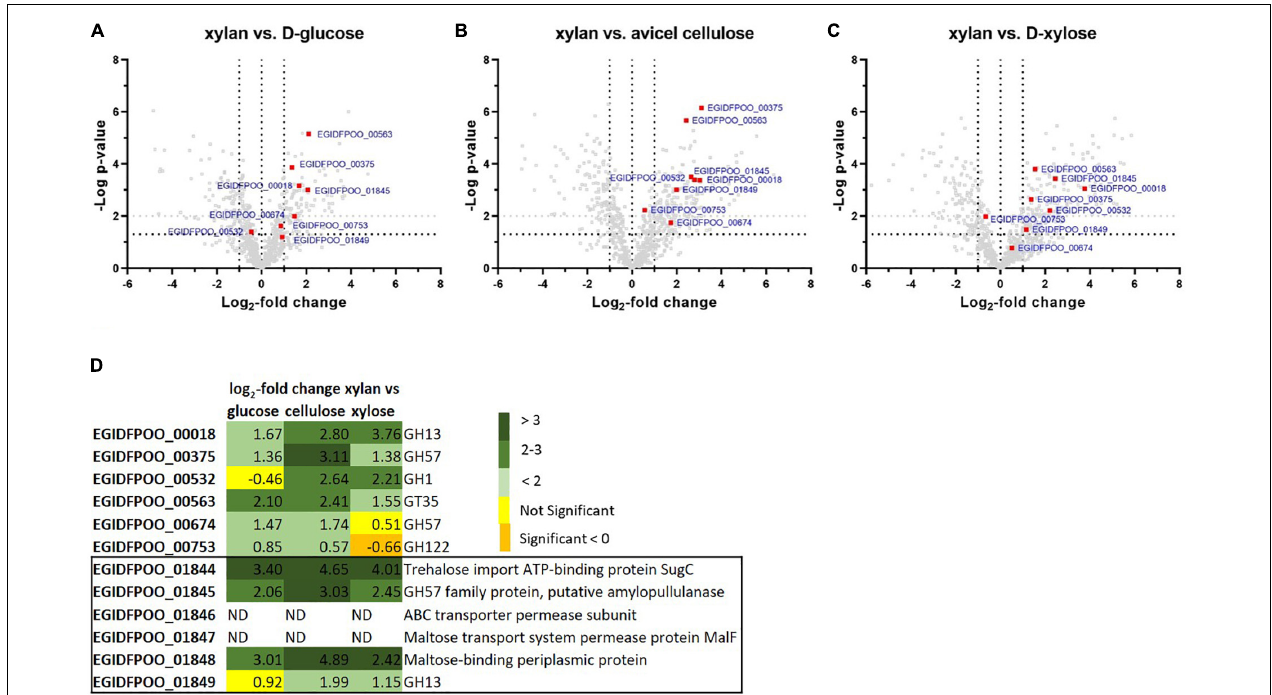
FIGURE 4 | Differentially abundant proteins in Thermococcus sp. strain 2319x1E cells grown on different carbon sources. The protein abundance profile of cells grown on beechwood xylan was compared with that of cells grown either on D -glucose (A) , Avicel R (cid:13) cellulose (B) or D -xylose (C) . The volcano plots show the p -value against the log 2 -fold change in protein abundance. Statistical significance was calculated based on a two-sample Student‘s t -test. Predicted CAZymes are depicted as red squares. Each treatment group comprised four biological replicates. (D) Table of differentially abundant CAZymes or selected sugar transport proteins with their respective log 2 -fold change and annotation. Yellow fields indicate non-significantly regulated proteins, orange fields indicate significantly downregulated proteins ( p < 0.05), whereas green fields indicate significantly upregulated proteins ( p < 0.05) with a log 2 -fold change > 1 (pale green: 1–2; moderate green: 2–3; dark green: > 3). Proteins that were absent in the filtered data are displayed as ND (not detected). The two GHs EGIDFPOO_01845 and EGIDFPOO_01849 belong to a gene cluster encoding further sugar transport proteins that is